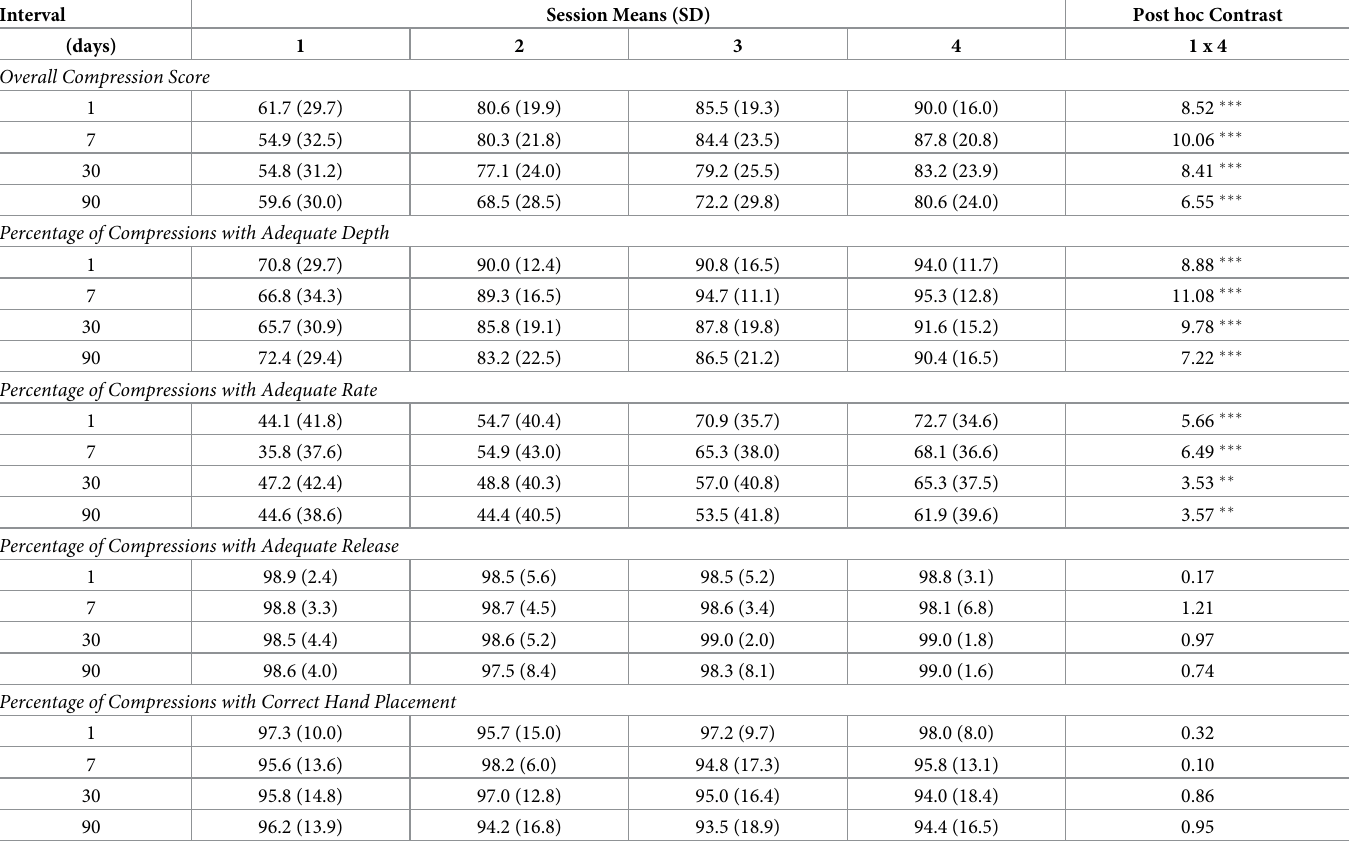
Table 1. Pretest means (SD) for compression measures across sessions and intervals. Contrasts provide post hoc comparisons of session 1 and 4 for each interval, with t-values and significance levels at � p < .05, �� p < .01, and ��� p <